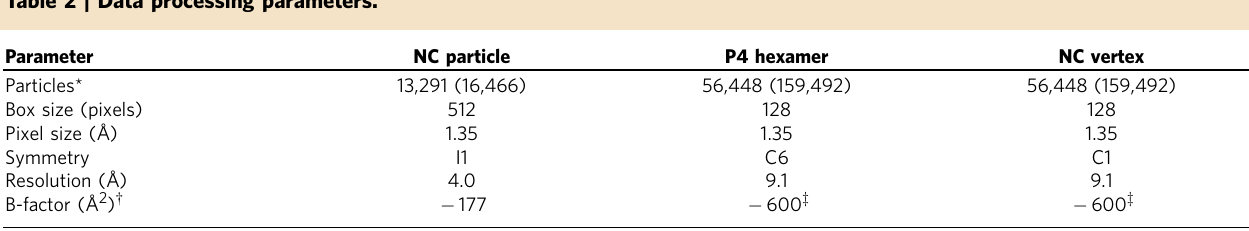
NC, nucleocapsid. *Numberofparticles(orsubparticlesinthecaseofP4hexamerandNCvertex)chosenforaveragingthefinalmapisgiven.Thenumberofallparticlesextracted fromthe micrographs(orallsubparticles extracted from particles) is given in parenthesis. w Inverse B-factor used for sharpening of the map. z Value of B-factor determined ad hoc